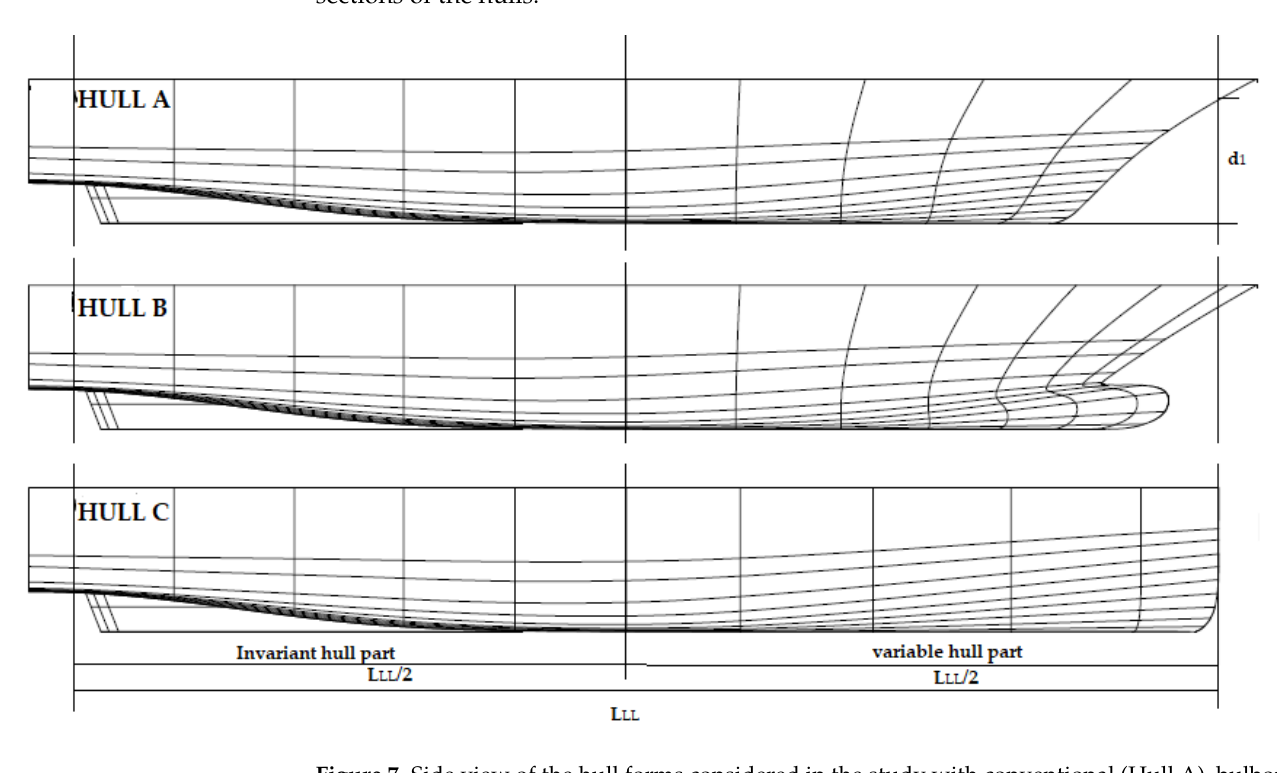
Figure 7. Side view of the hull forms considered in the study with conventional (Hull A), bulbous (Hull B) and vertical bow (Hull C), respectively.